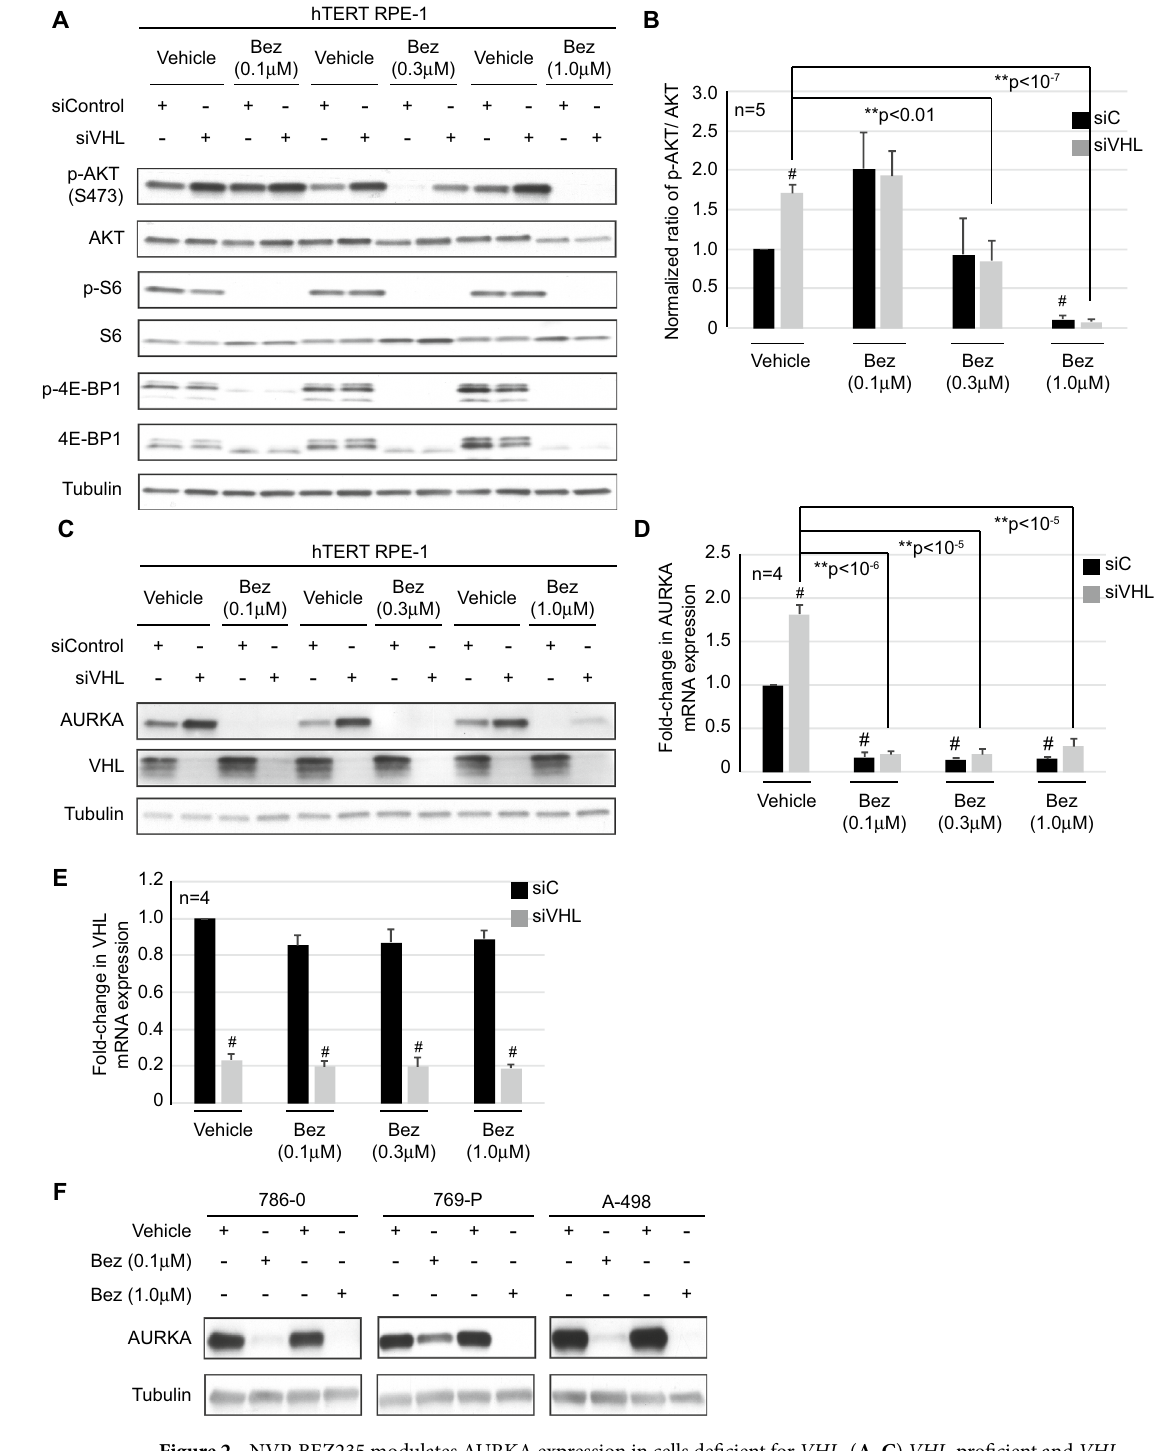
Figure 2. NVP-BEZ235 modulates AURKA expression in cells deficient for VHL . ( A , C ) VHL -proficient and VHL - deficient cells were treated with Vehicle or NVP-BEZ235 (Bez) as indicated and blotted for the antibodies shown. ( B ) Densitometric analysis graphed to show the ratio of phospho-AKT to total AKT. Black bars—siC (scrambled control) and gray bars—siVHL. # Statistical significance (Students t-test) compared to vehicle (DMSO) treated control (siC) (p < 0.001), **statistical significance (Students t-test) compared to vehicle treated siVHL (p-values as indicated). ( D ) Graphical representation of densitometric data showing fold-change in AURKA mRNA expression. Black bars—siC and gray bars—siVHL. # Statistical significance (Students t-test) compared to vehicle (DMSO) treated control (siC) (p < 0.001), **statistical significance (Students t-test) compared to vehicle treated siVHL (p-values as indicated). ( E ) Graphical representation of densitometric data showing fold-change in VHL mRNA expression. Black bars—siC and gray bars—siVHL. # Statistical significance (Students t-test) compared to siC for each of the treatment conditions (p < 0.05). ( F ) Three VHL -null RCC cells lines (786-0, 769-P, A-498) treated with Vehicle and NVP-BEZ235 (Bez) at the indicated doses and blotted as